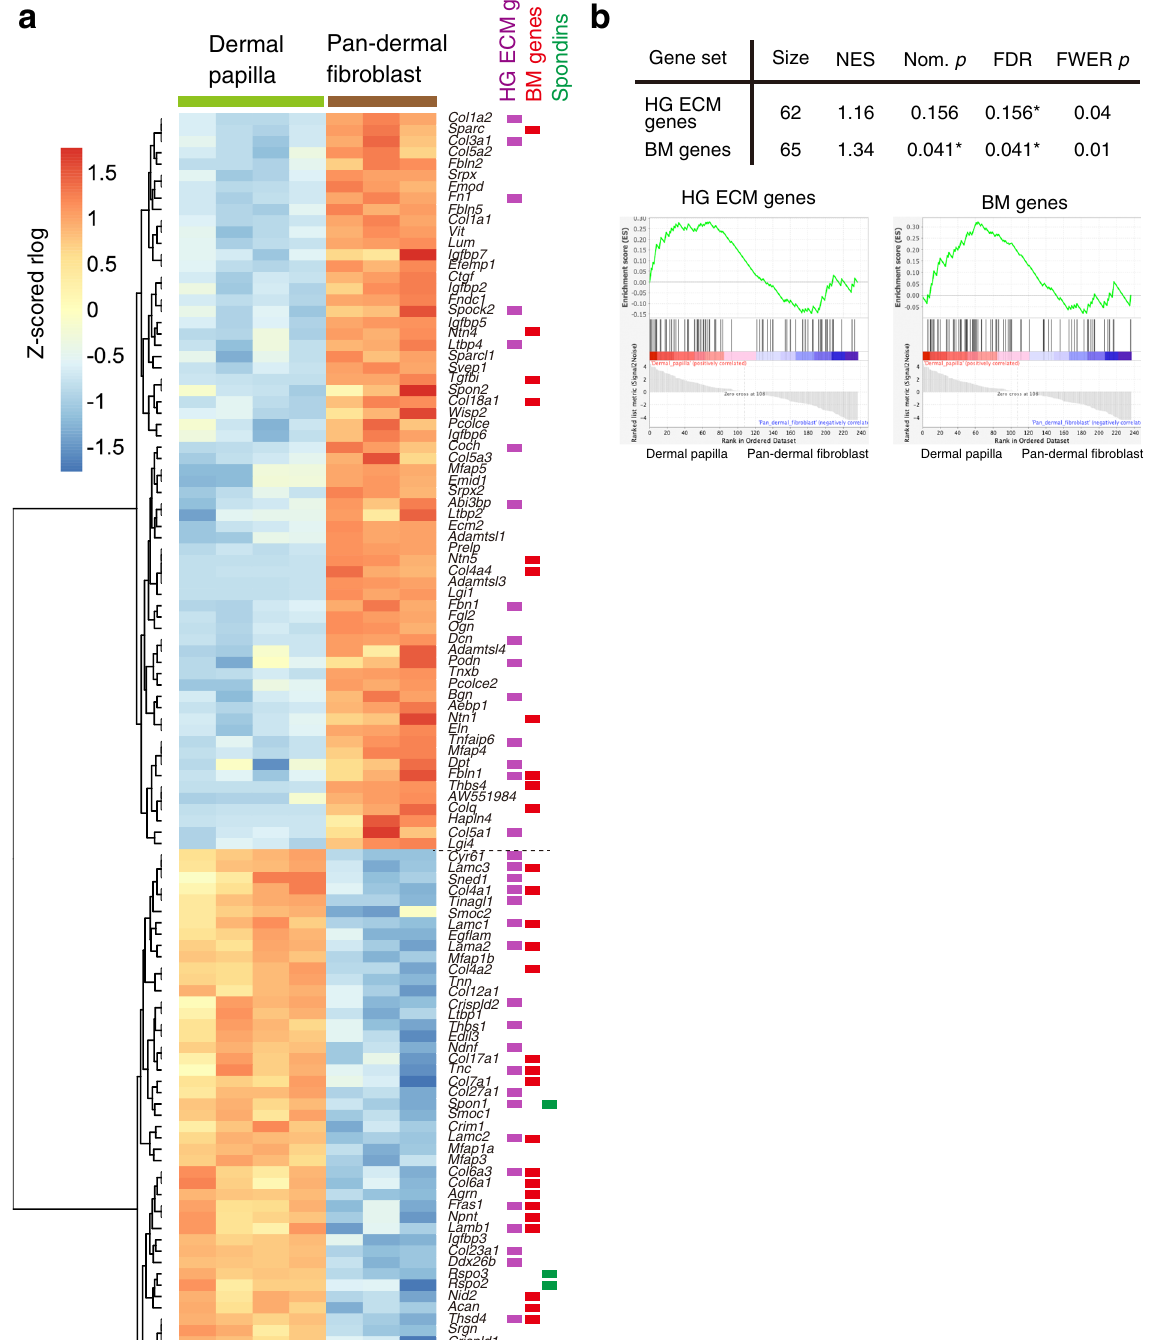
asymmetrically organized side-speci fi c heterogeneity in BM composition and structure in this inter-tissue interface. Requirement of epithelial laminin α 5 in hair cycle regulation . Laminin α 5 appeared to be a major cell adhesion ligand for both